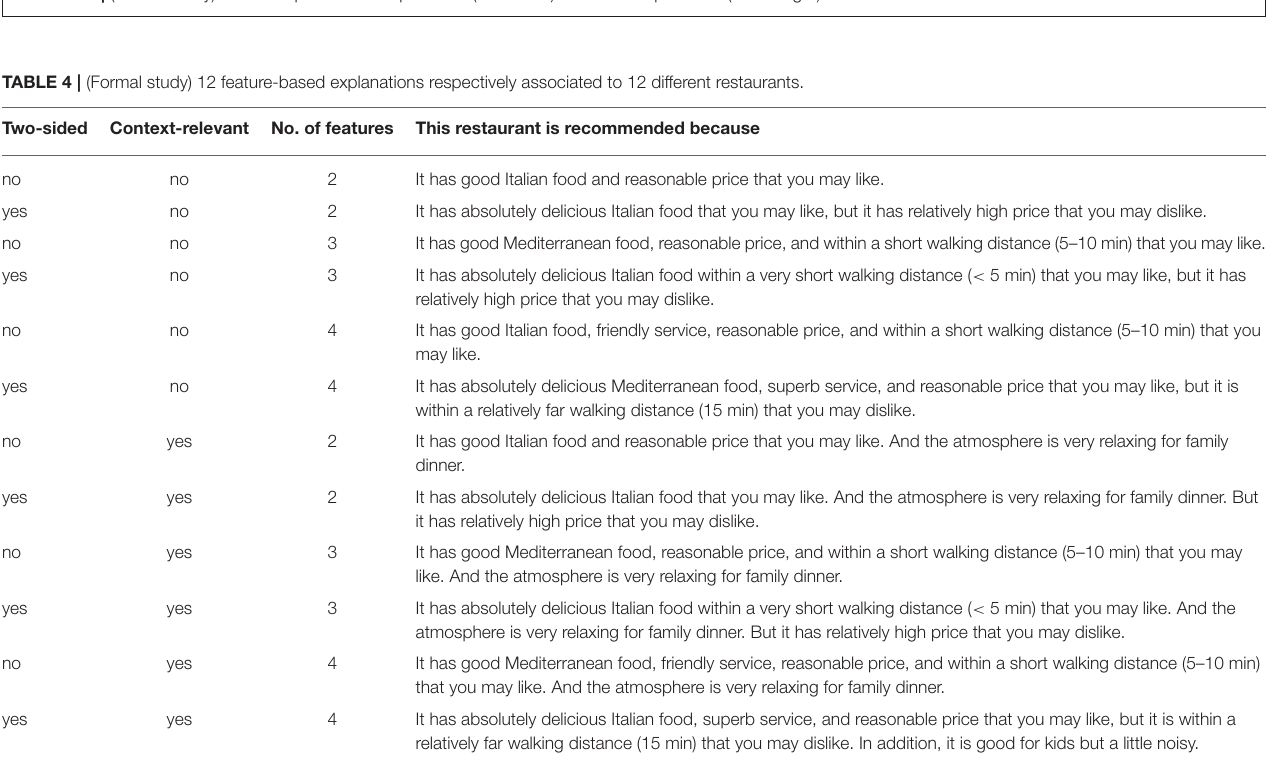
FIGURE 2 | (Formal study) The examples of text explanation (on the left) and voice explanation (on the right).